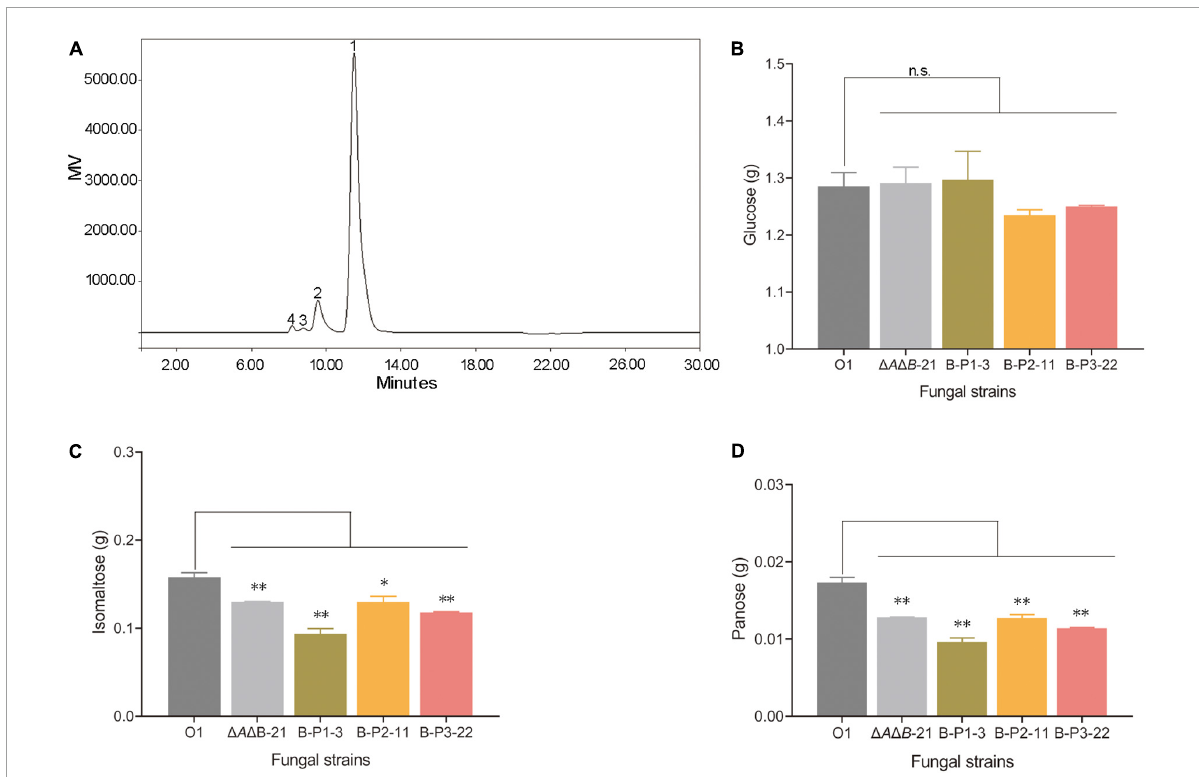
FIGURE4 Analysis of starch liquefaction and saccharification products in supernatants of strain O1, (cid:49) A (cid:49) B -21, and domain-OE strains. (A) Analysis of reaction products by HPLC. Peak 1, glucose; peak 2, isomaltose; peak 3, panose; peak 4, unknown product. (B) Total amount of glucose detected in reaction mixtures. (C) Total amount of isomaltose detected in reaction mixtures. (D) Total amount of panose detected in reaction mixtures. Values are means ± SD ( n = 3 repeats). ∗∗ P < 0.01 (Student’s t -test), ∗ P < 0.05 (Student’s t -test), n.s., not